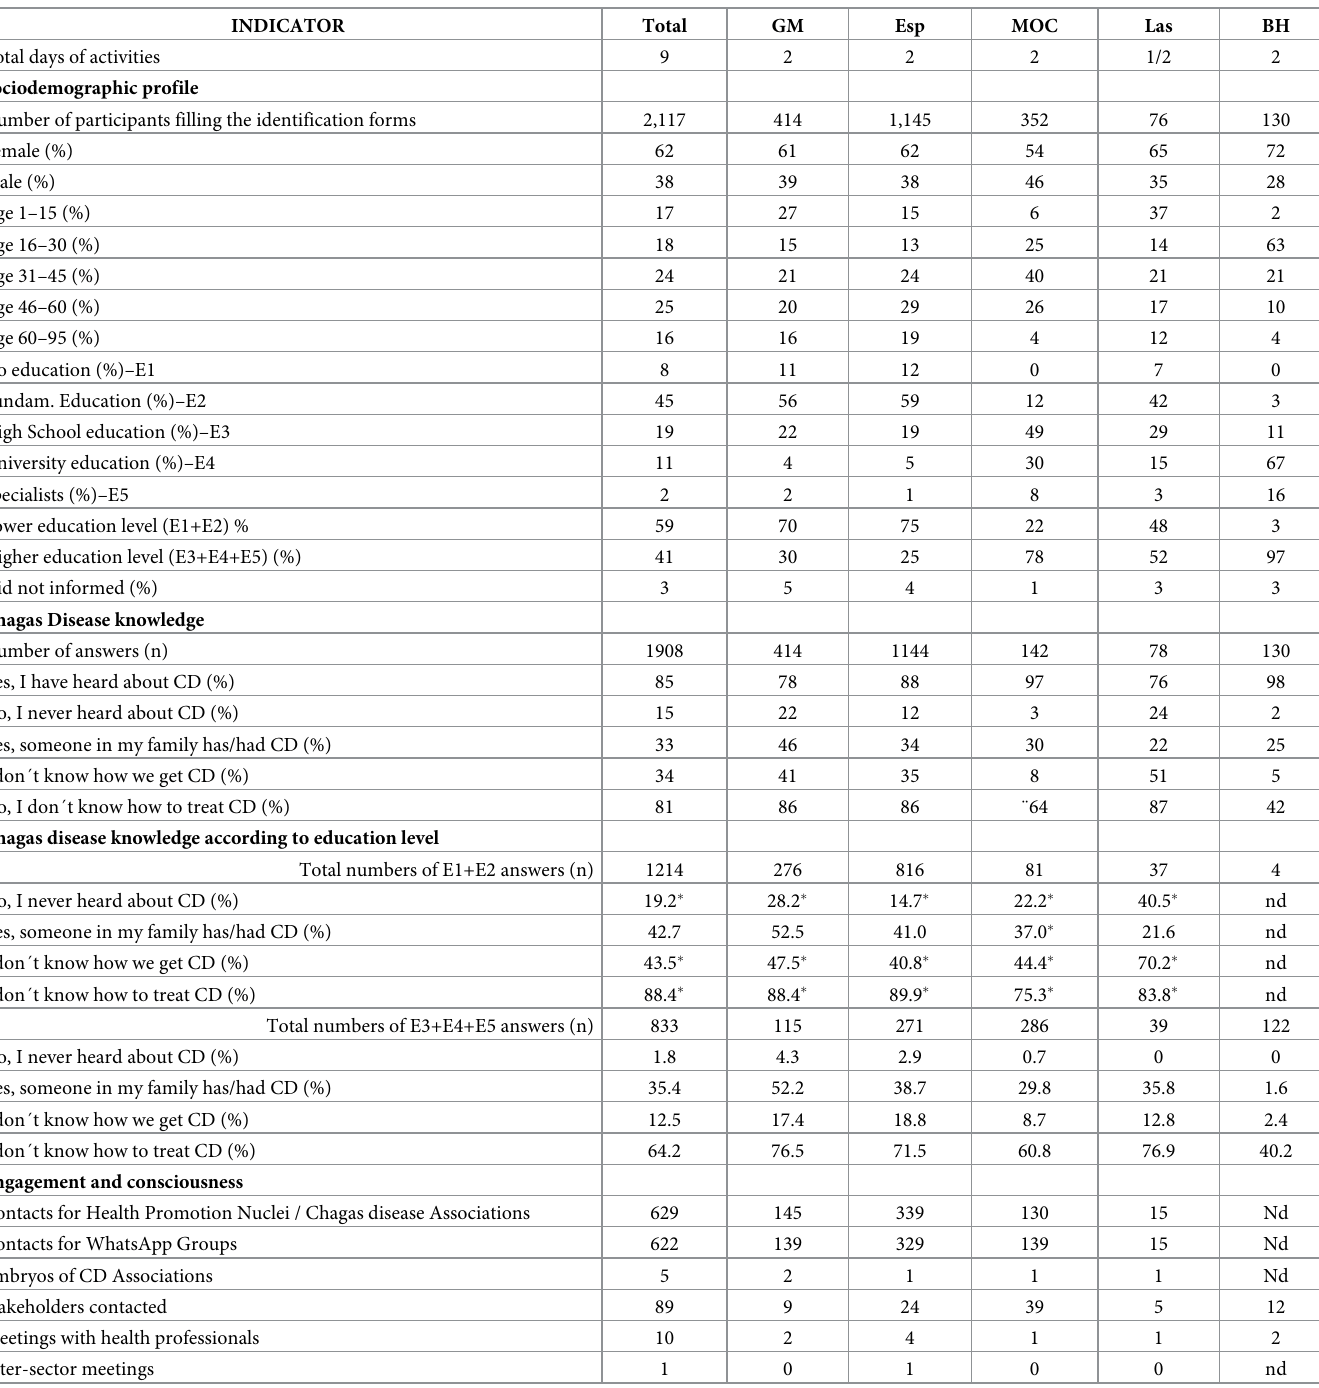
Table 2. Chagas Express XXI quantitative indicators and results: profile of participants, knowledge about Chagas disease, engagement, and awareness. INDICATOR Sociodemographic profile